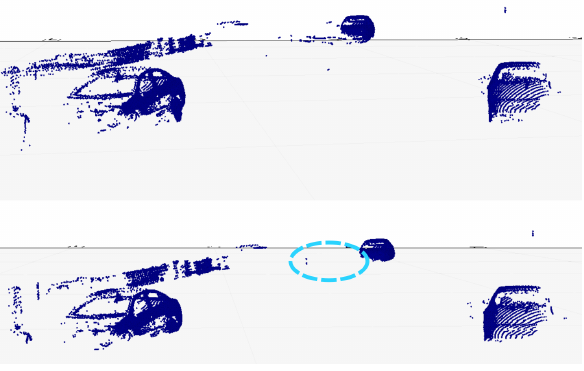
Figure 8. Visualization of the points labeled as car. Top part shows point cloud before removing the ground points and at the bottom part after removing the ground